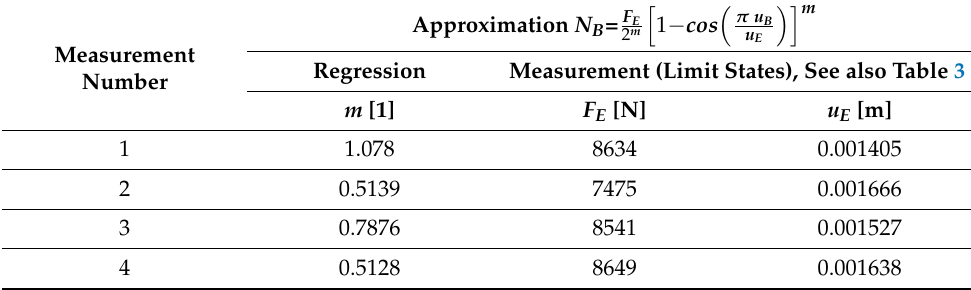
Table 4. The pull-out test results (a simple one-parameter approximation of measured data).